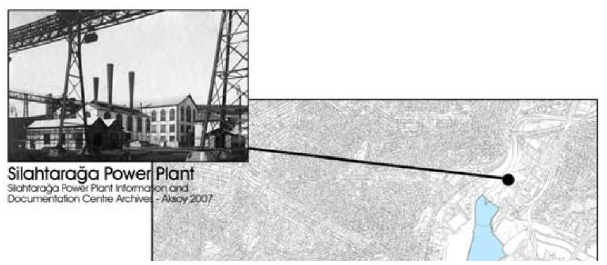
Figure 4. The place of Silahtaraga power plant in golden horn